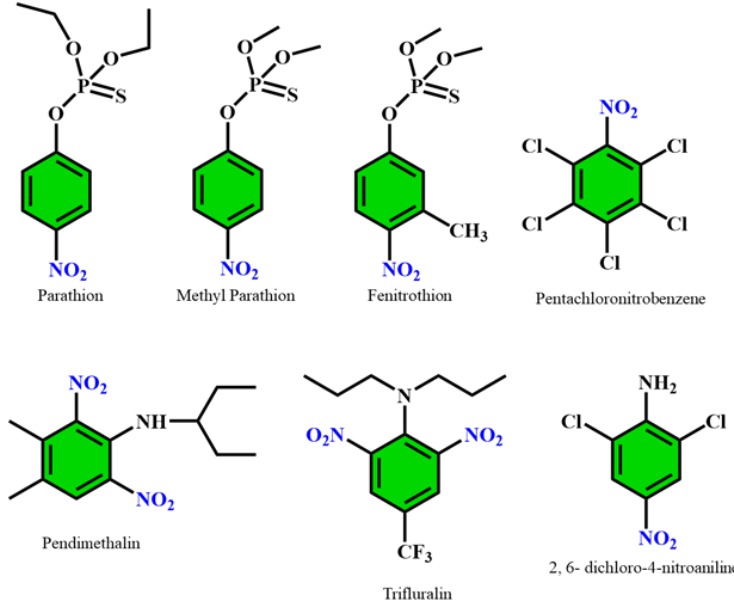
Figure 7. Chemical structures of some nitro group-containing pesticides.